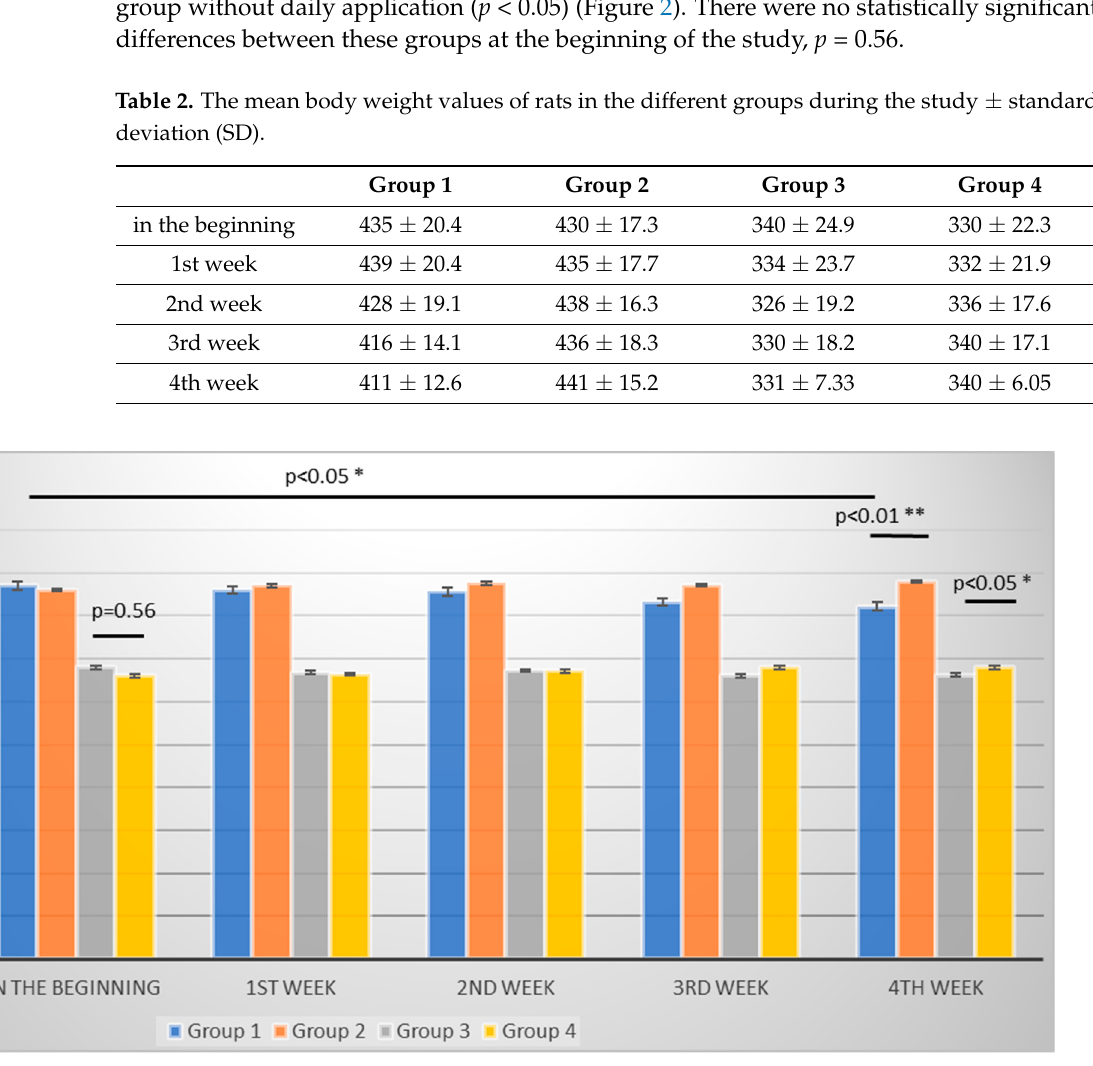
Figure 2. Average body weight, measured in grams, in the different groups, presented by week. Statistical signi fi cance: * p < 0.05, ** p < 0.01.